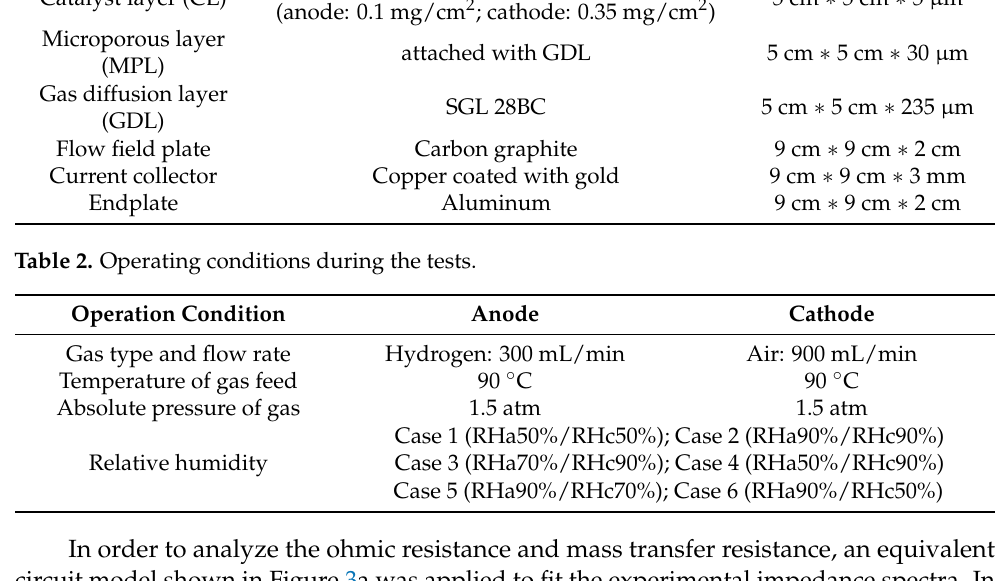
Figure 2. Flow field of the PEMFC.